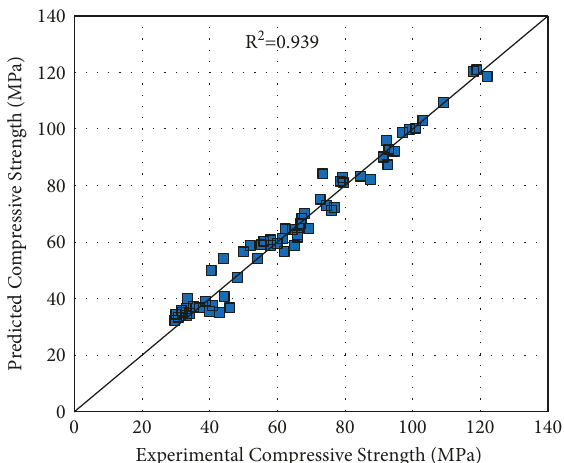
Figure 6: Experimental vs. forecasted compressive strengths for ANN-BAT-1L (14) model for testing data.